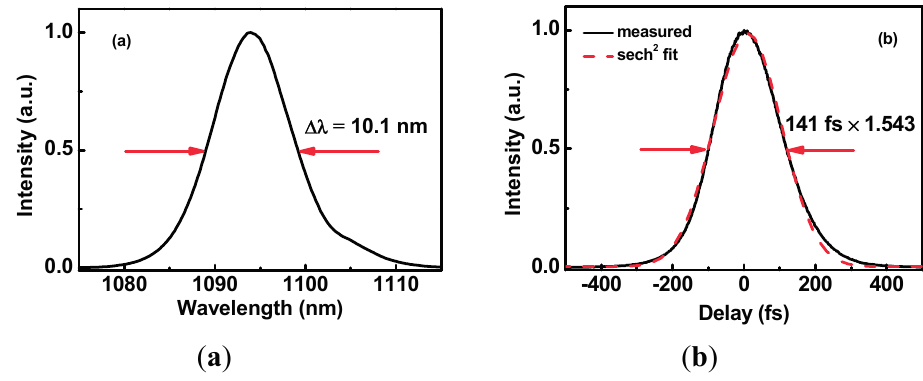
Figure 4. Mode-locked output power (red dots) versus the pump power. Blue dots indicate the CW power when mode-locking was terminated.